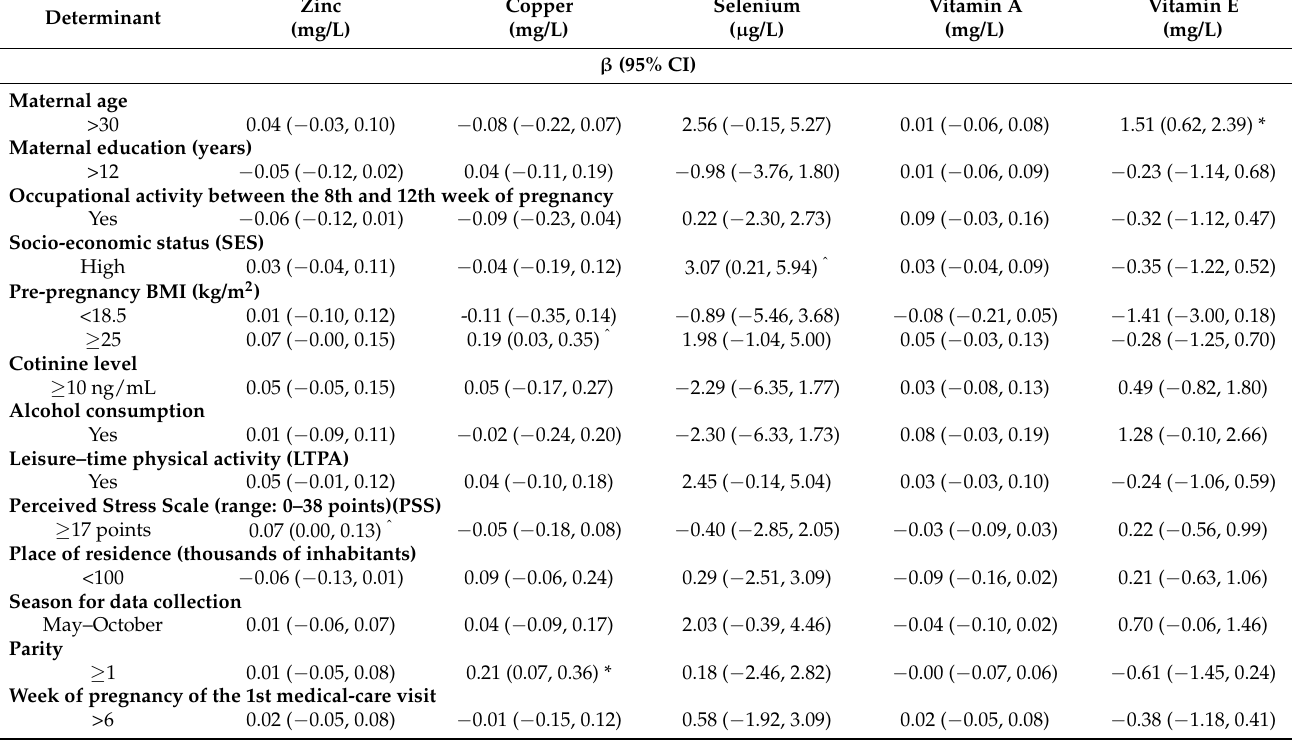
Table 1. Adjusted effects of the explanatory factors on microelements and vitamins concentrations in blood plasma samples collected during the 1st trimester of pregnancy estimated by multivariable linear regression